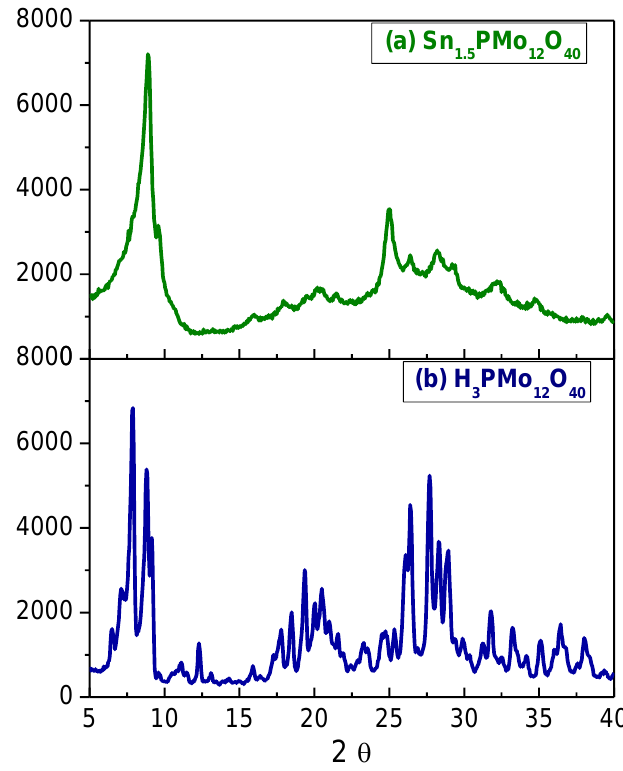
Figure 1. Diffractograms of ( a ) Sn 1.5 PMo 12 O 40 catalyst and ( b ) its precursor H 3 PMo 12 O 40 . The diffraction peaks noticed in the diffractogram of tin phosphomolybdate salt underwent enlargement and loss of intensity triggered by the presence of Sn (II) cation. The crystallite size was calculated by Scherrer Equation (Equation (1)), where λ corresponds to the Cu K α radiation, and β is the full width at half-maximum for a reflection maximum located at 2 θ . The protons exchange by Sn 2+ led to a lower crystallite size (25.5 to 9.9 nm; phos-